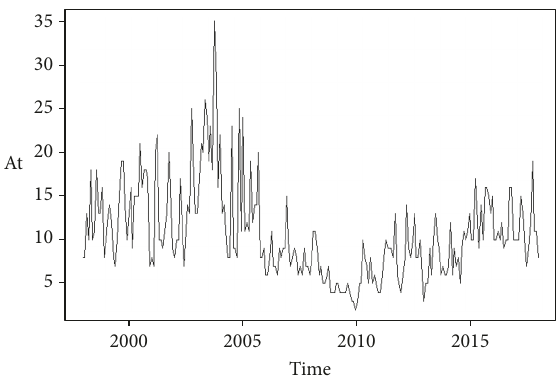
Figure 1: Overview of monthly DGD